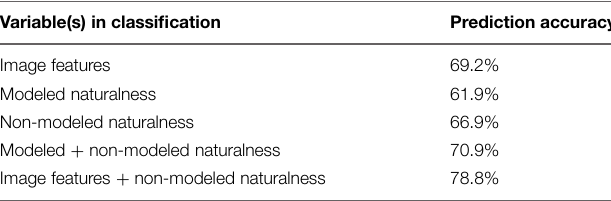
TABLE 6 | Results of quadratic discriminant classification of esthetic preference for images using different